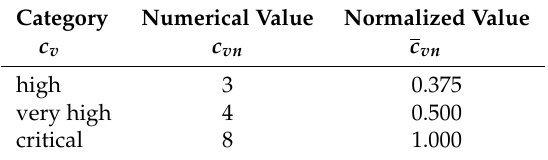
Table 1. An example mapping between categories and their associated numerical